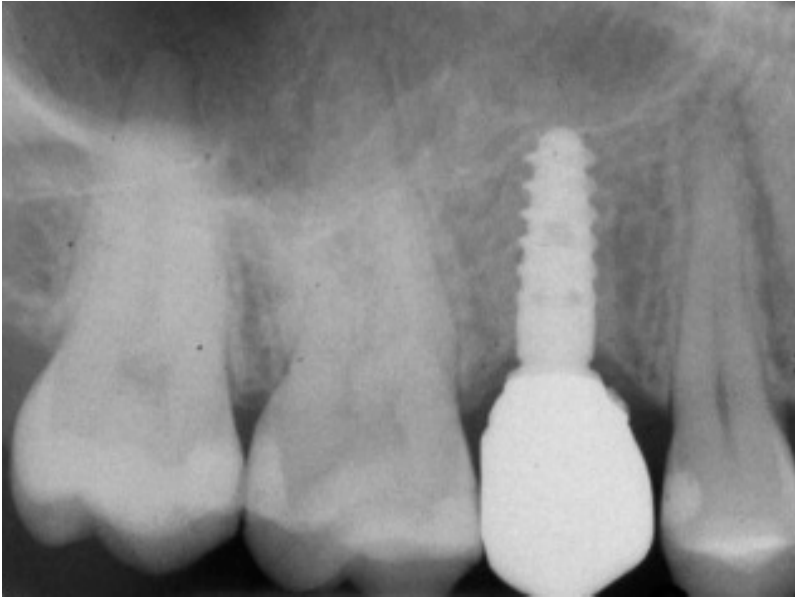
Figure 15. One-year follow-up rx control of the implant supported crown.